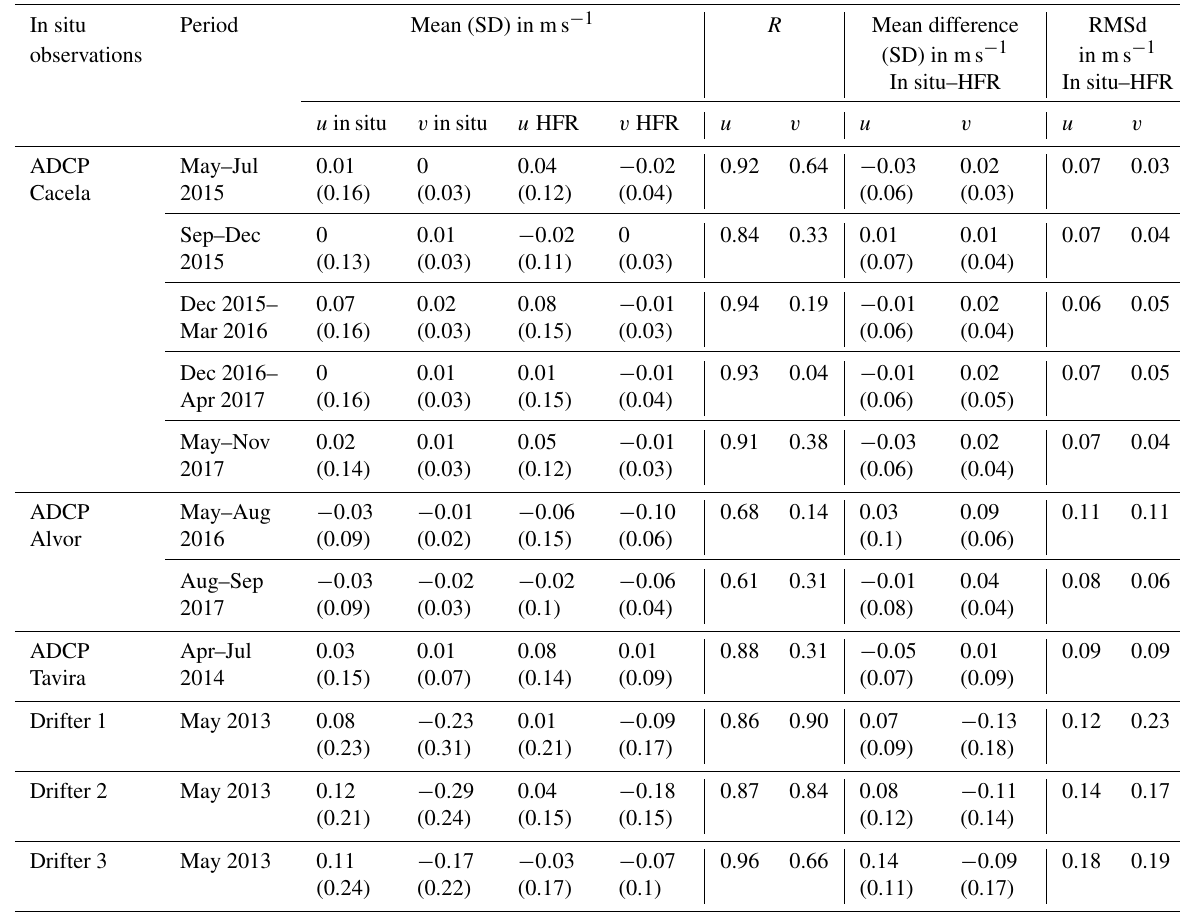
Table 1. Validation statistics between HFR and in situ (i.e. ADCP, drifter) measurements of the u and v flow components. In